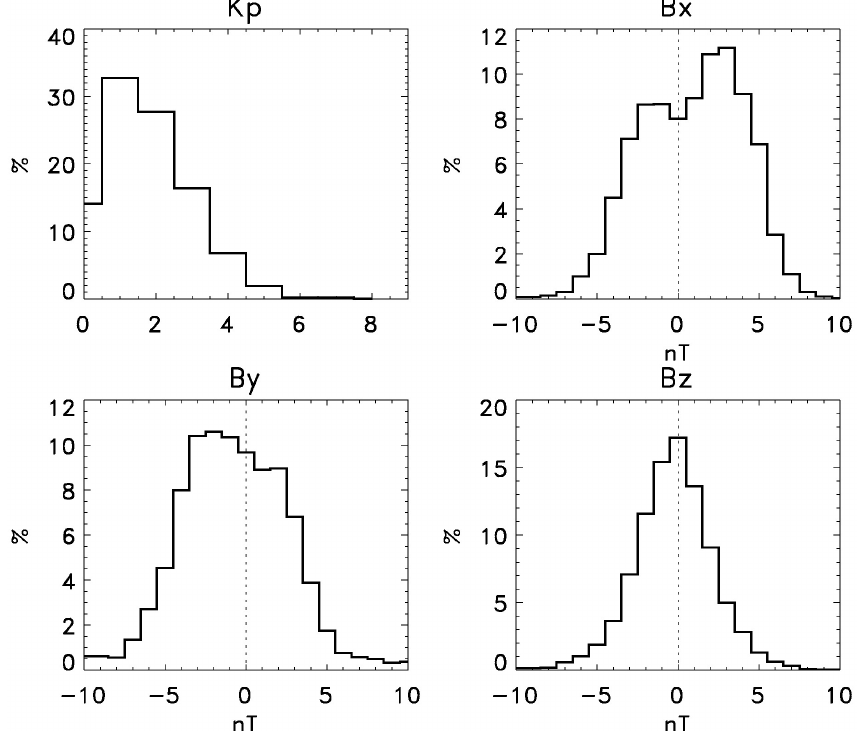
Fig. 1. Distributions of values for Kp and the three IMF components corresponding to the whole period included in the database. They are normal distributions centred around very small average values ( (cid:0)(cid:11)(cid:10)(cid:4)(cid:3)(cid:13)(cid:12)(cid:2)(cid:5)(cid:8)(cid:7)(cid:9) (cid:0)(cid:15)(cid:14)(cid:16)(cid:3)(cid:17)(cid:12)(cid:2)(cid:5)(cid:8)(cid:7)(cid:18) nT, nT and nT), and (cid:19)(cid:21)(cid:20) is (cid:22)(cid:24)(cid:23) .